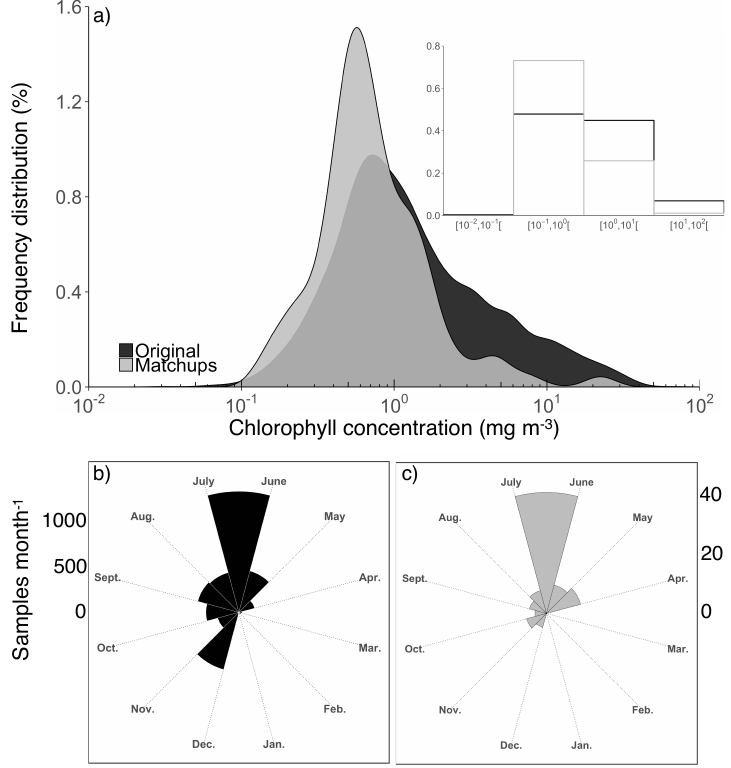
Figure 1. Frequency distribution of the 2927 original Chl measurements, 93 of which were considered valid match-ups. ( a ) Chl concentration frequency distributions (inset presents the same data binned by order of magnitude). Temporal distributions of Chl concentration for ( b ) the original and ( c ) match-up